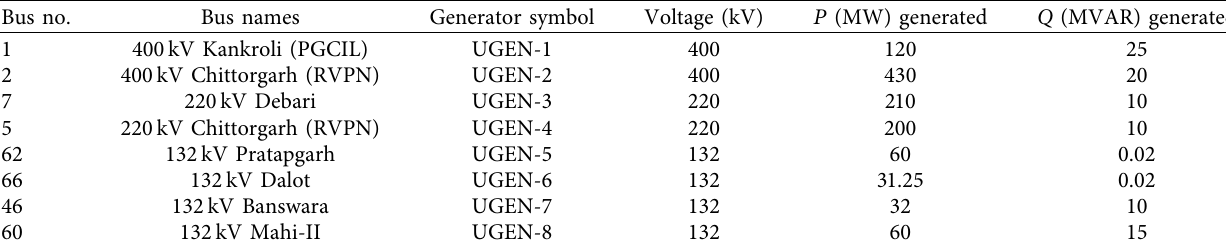
Table 3: Details of generators connected to test system.